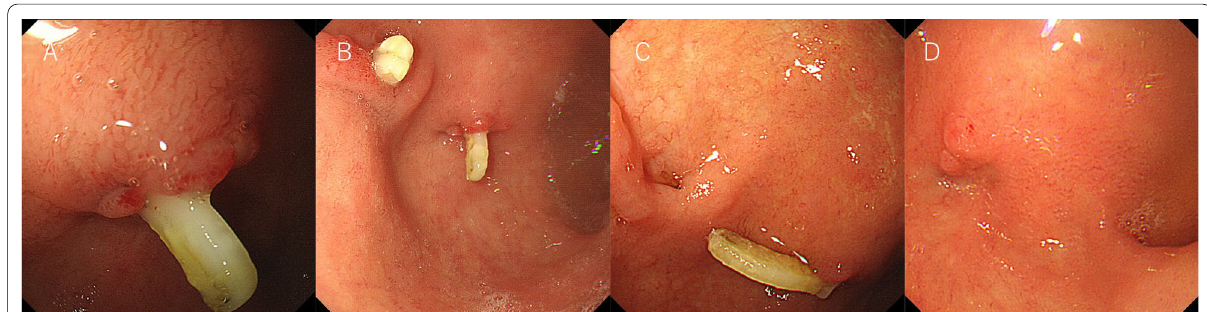
Fig. 1 Upper gastrointestinal endoscopy after a laparoscopic right hemihepatectomy. A Upper gastrointestinal (GI) endoscopy shows 1 medium-large (ML) NAPC at the anterior aspect of the duodenal bulb; 2 years after the operation. B Follow up GI endoscopy performed 2 months after the first upper GI endoscopy shows 2 ML NAPCs at the anterior aspect of the duodenal bulb. C Follow up GI endoscopy performed 5 months after the first upper GI endoscopy shows 1 ML NAPC at the anterior aspect of the duodenal bulb. D The NAPC fell out, without any procedure, after 7 months of observation